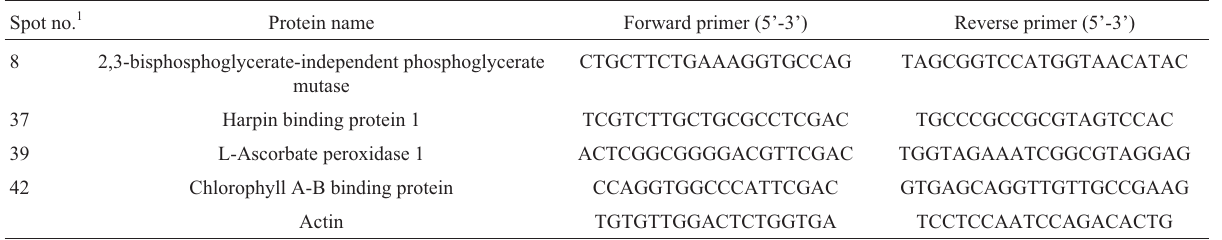
Table 1 - Primer sequences used for quantitative real-time PCR. Spot no.